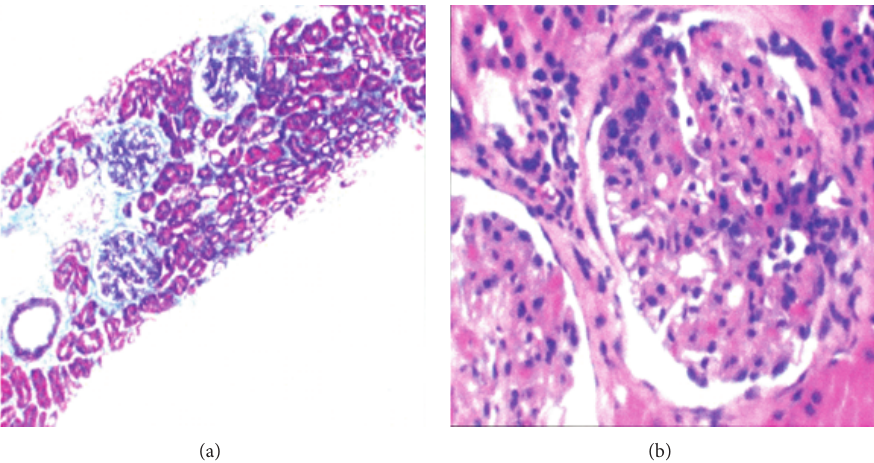
Figure 3: Kidney biopsy of the patient indicated class III lupus nephritis. Less than 50 percent of glomeruli are affected by light microscopy. The glomerulonephritis is almost